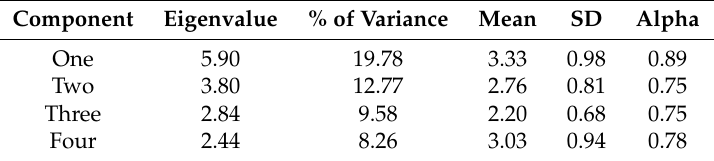
Table 1. Eigenvalues, percentage of variance explained, average value and standard deviation of the items in each factor and internal consistencies (alphas).